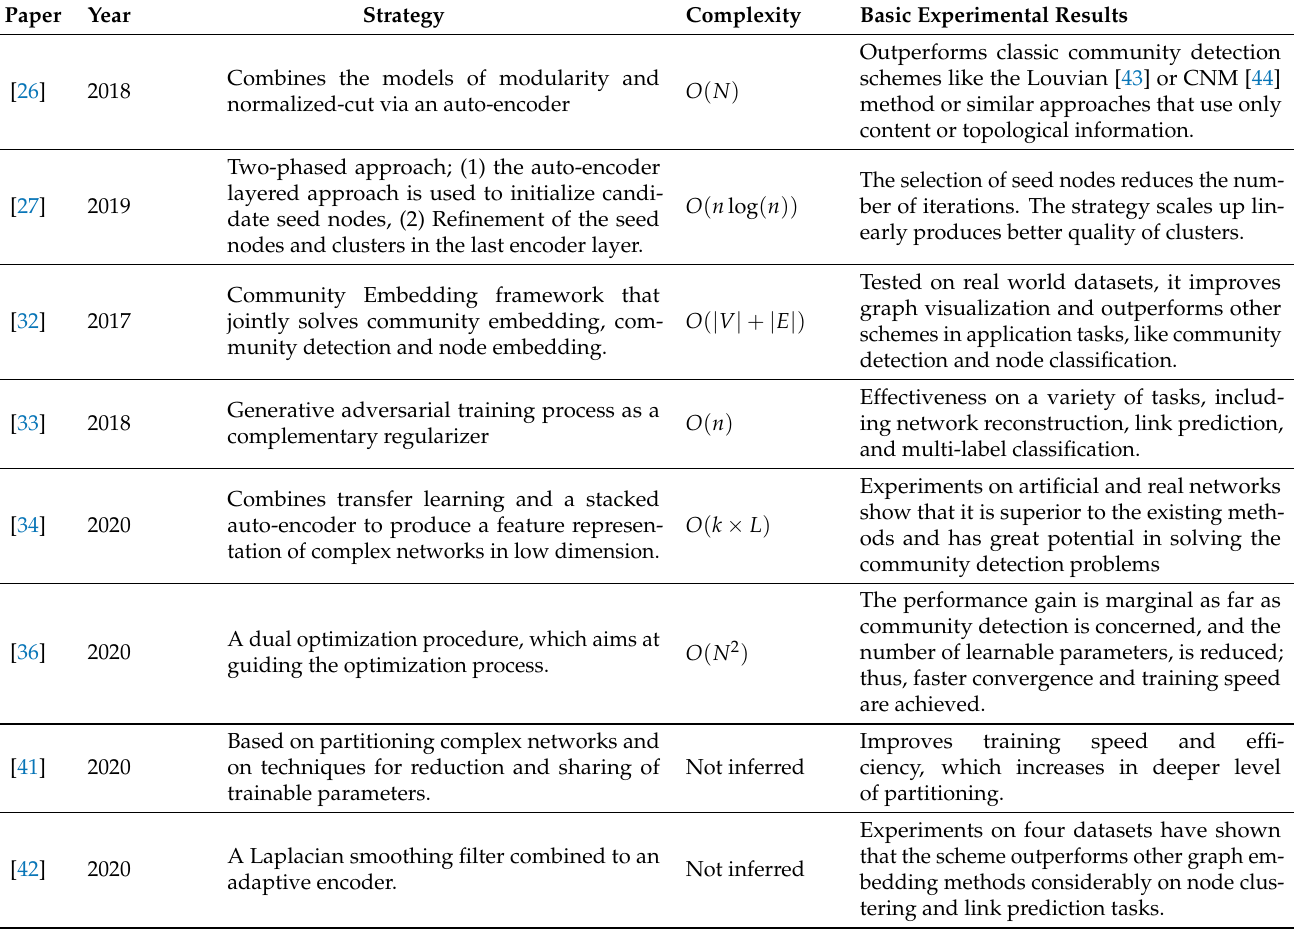
Table 1. Auto-encoder based community detection strategies. Strategy Complexity Basic Experimental